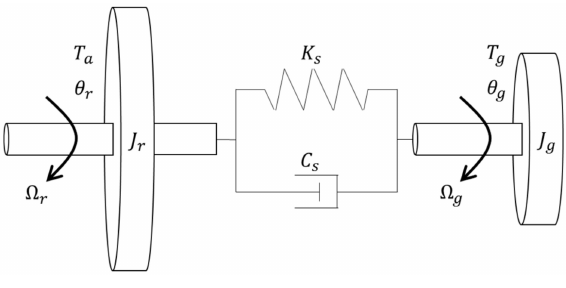
Figure 3. Drivetrain